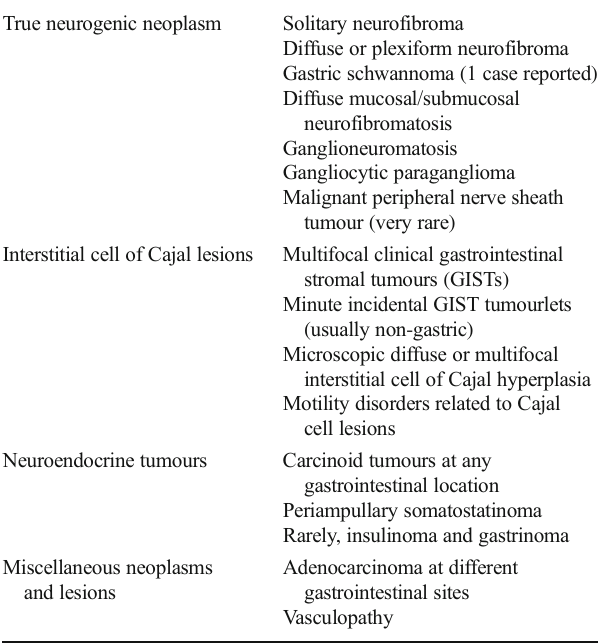
Different type of gastrointestinal tract lesions associated with NF1 True neurogenic neoplasm